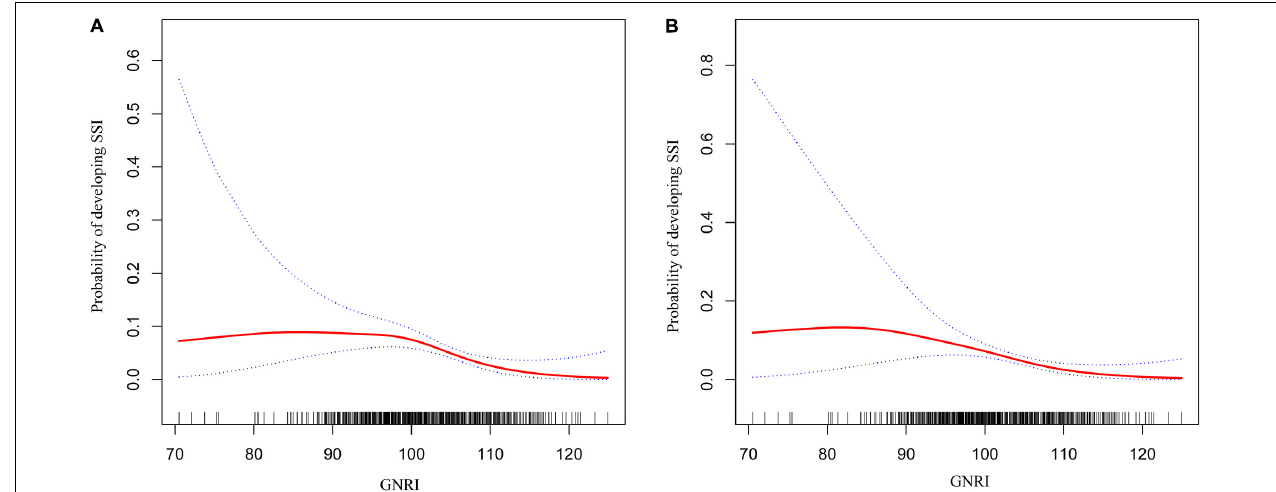
FIGURE 2 | Two-piece piecewise regression and smooth curve-ftting for association between GNRI and the risk of SSI in gynecologic oncology patients. (A) The two-piece wise models unadjusted for any variables. (B) The two-piece wise models adjusted for age, BMI, season of admission, surgical history in recent 3 months, hypertension, diabetes, coronary artery disease, COPD/emphysema, moderate or severe renal disease, liver disease, bacterial vaginosis, aCCI, FIGO stage, ASA class, site of cancer, Barthel Index, MFS score, preoperative steroid use, glucose, albumin, ALT, total bilirubin, platelet count, hematocrit, TLC, WBC, preoperative hair removal, preoperative LOS, antibiotic prophylaxis within 0.5–1 h before operation, surgical approach, operative time, estimated blood loss, blood transfusion, emergent surgery, NNIS risk index, and GNRI. Note: the red line represents the best-fit line, and the blue lines are the 95% confidence